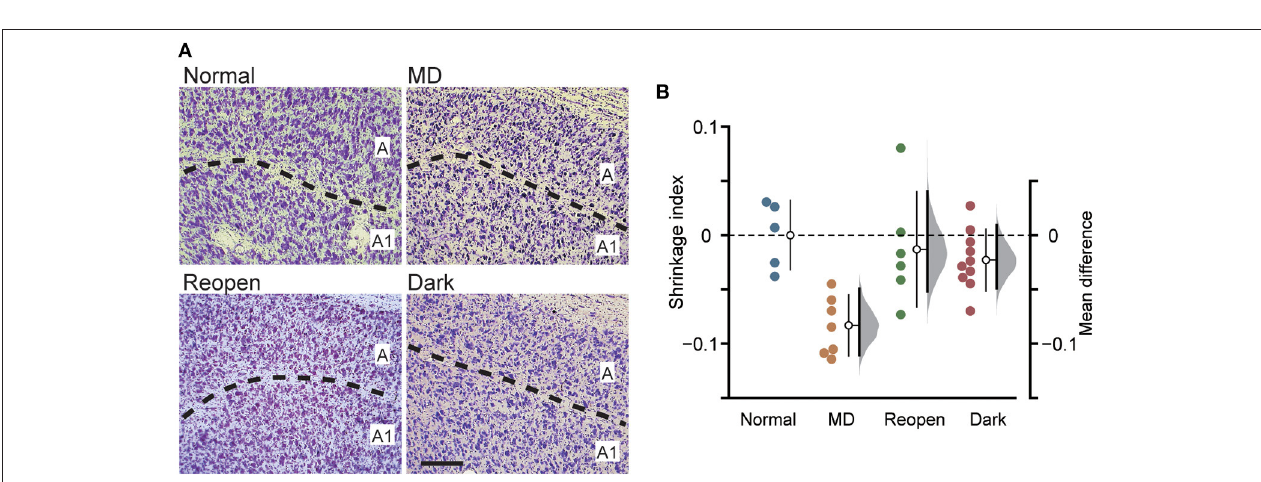
FIGURE 3 | Measurement of the soma size of LGN neurons. (A) Examples of the Nissl-stained sections of the LGN in each animal group. The dotted lines represent the border between layer A and A1. Scale: 200 µ m. (B) Each symbol represents the shrinkage index of individual animals. The other conventions are the same as in Figure 1C